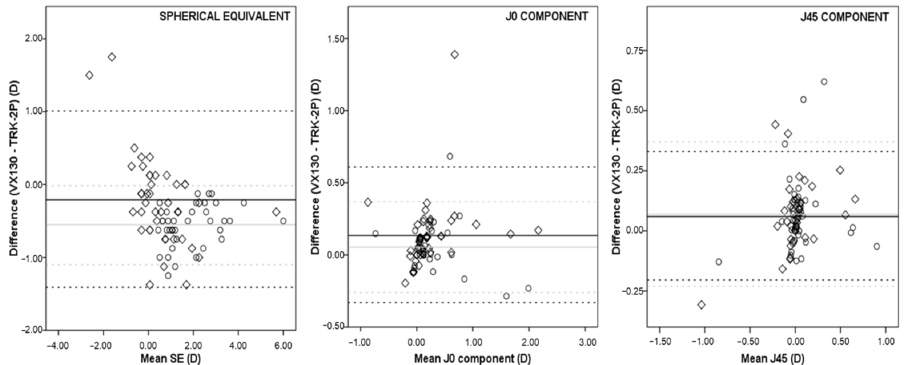
Figure 2. Differences in spherical equivalent ( left ), J 0 component ( center ), and J 45 component ( right ) between VX130 and TRK-2P in hyperopia group without cycloplegia (rhombus; mean bias represented by a solid black line and the 95% limits of agreement by dashed black lines) and with cycloplegia (circle; mean bias represented by a solid grey line and the 95% limits of agreement by dashed grey lines).